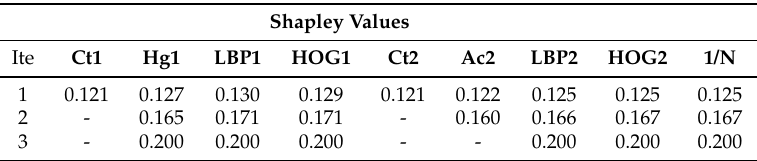
Table 10. Shapley values and interaction indexes obtained when applying the first iteration of the selection process on breast MRI and DECEDM selected texture